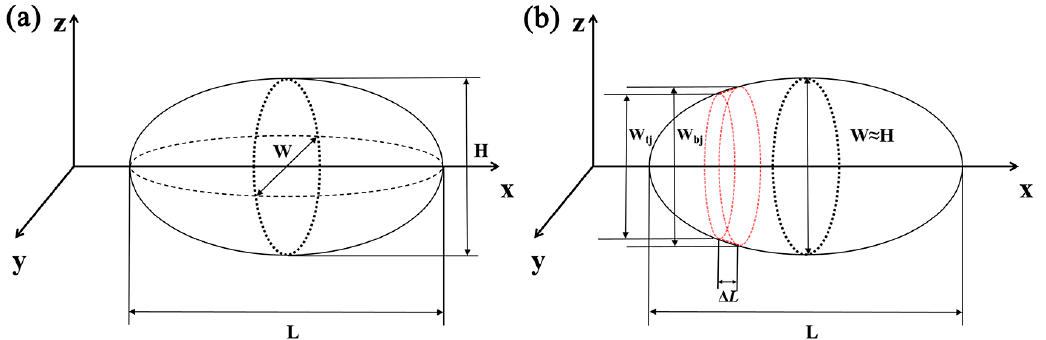
Figure 2. ( a ) The dimensions of an ellipsoid; ( b ) the partitioning and calculation of an ellipsoid.